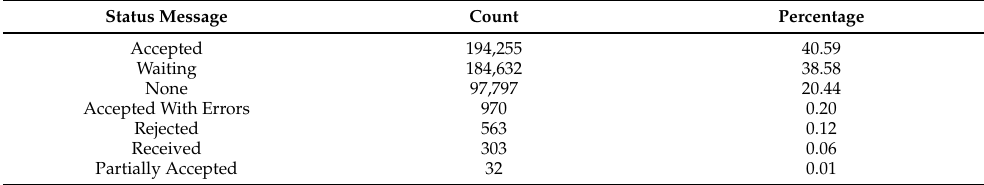
Table 21. Queueing system messages by ack status.